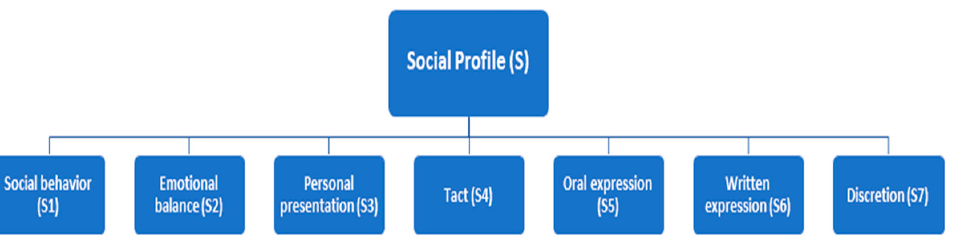
Figure 8. Subcriteria of the Social Profile criterion.